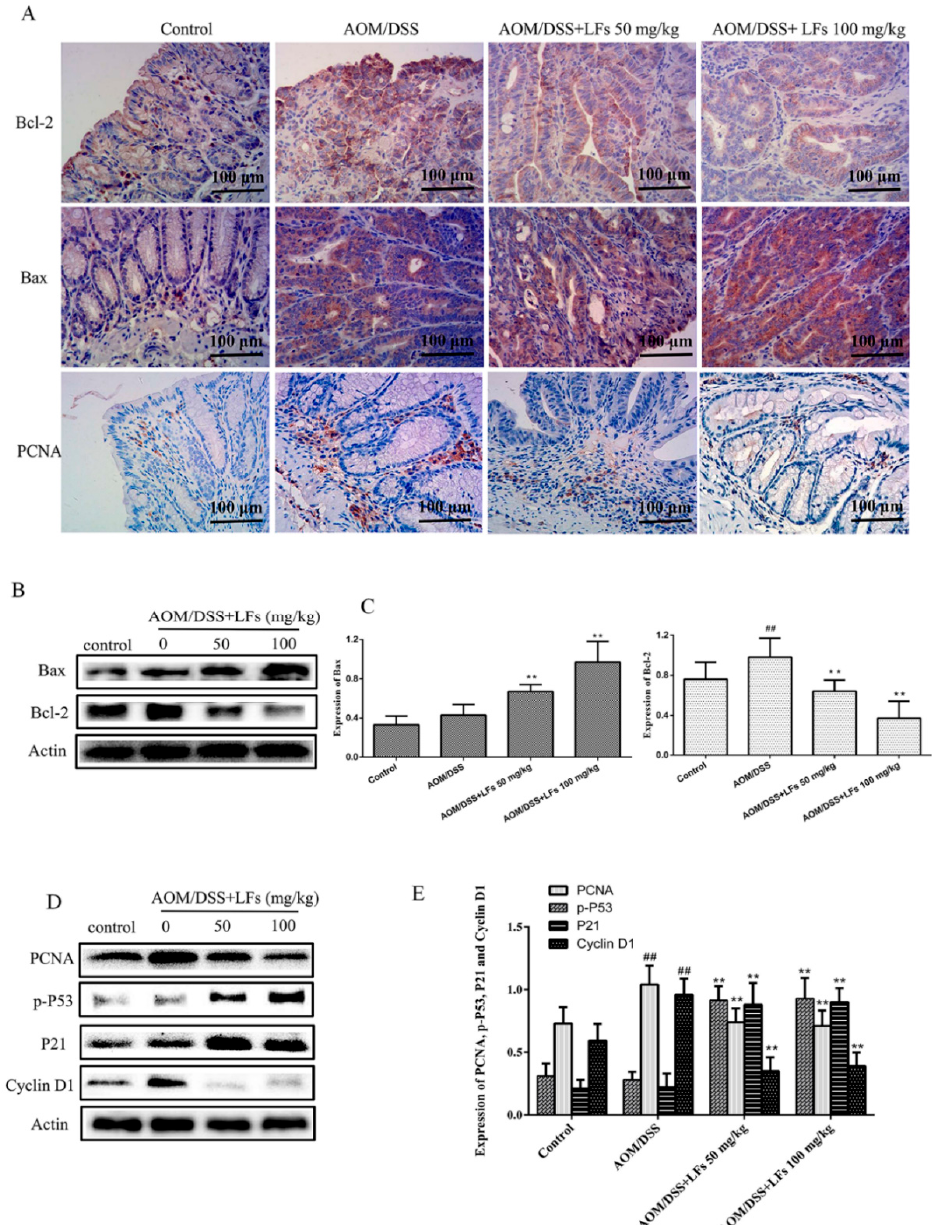
Figure 3. Effects of LFs on expression of proteins associated with proliferation and apoptosis in colonic tissues: ( A ) Immunohistochemical staining of Bax, Bcl-2, and PCNA in colonic tissues; ( B , C ) Western blot of Bax and Bcl-2 expression in colonic tissues and semi-quantitative analysis of these proteins. Data are presented as mean ± SD. ** p < 0.01 vs. model, ## p < 0.01 vs. vehicle control; ( D , E ) Western blot of PCNA, p-P53, P21, and CyclinD1 expression in colonic tissues and semi-quantitative analysis of these proteins. Data are presented as mean ± SD. ** p < 0.01 vs. model, ## p < 0.01 vs. vehicle control. Next, epithelial proliferation was evaluated using PCNA staining and Western blot